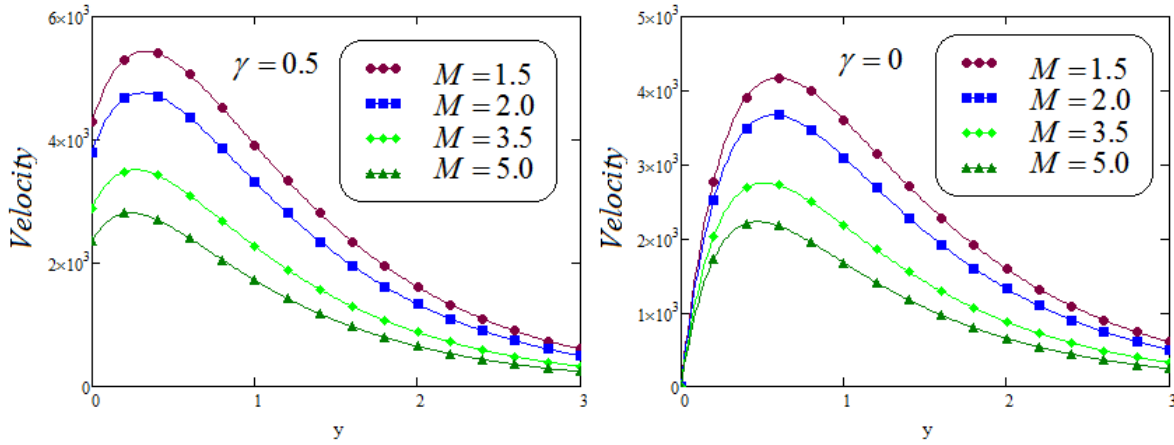
Figure 5. Velocity for varied values of M with and without slip effect γ when f ( t ) = e at , a = 0.25, t = 1.5, α = 0.5, β = 0.3, Gr = 3.5, λ 1 = 0.6, λ 2 = 0.2, P r = 0.71.